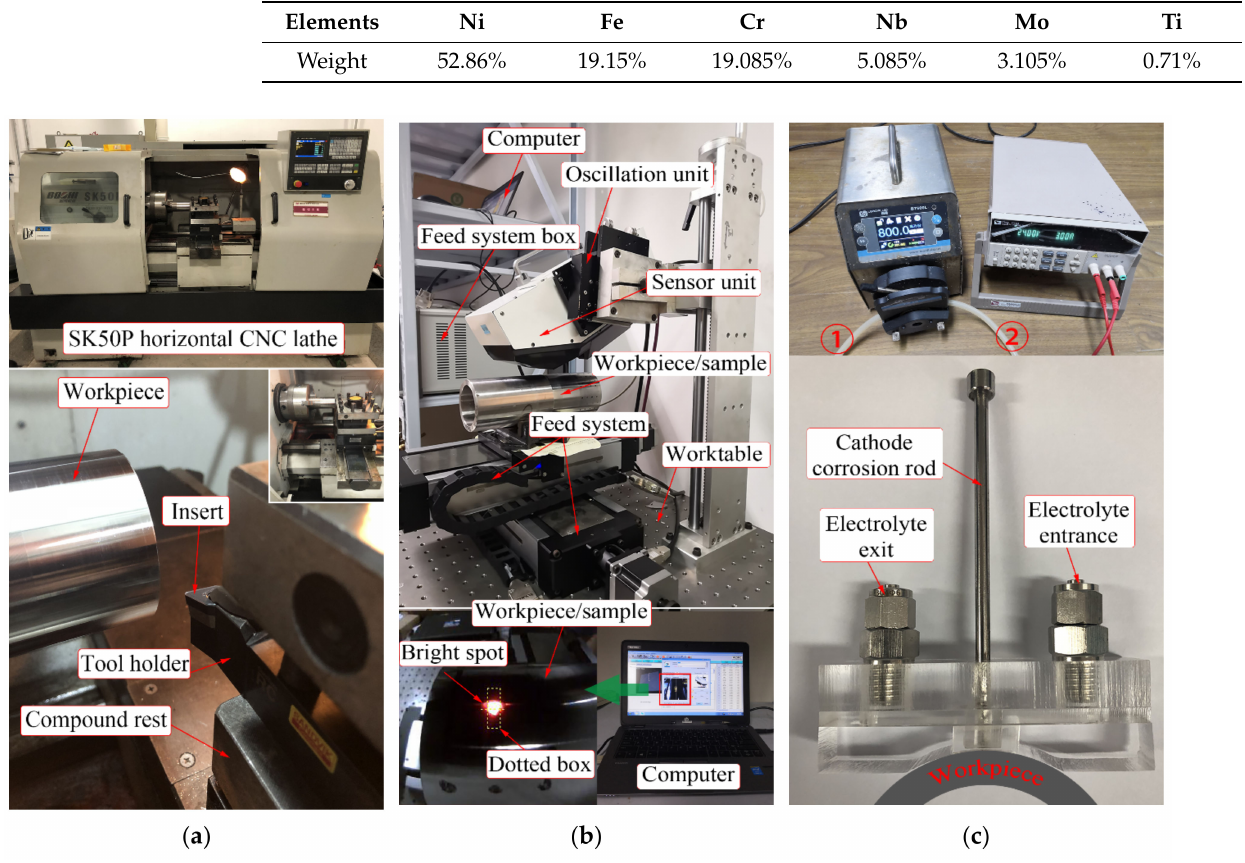
Table 4. The main elements and weight of Inconel 718 pipes used in experiments.